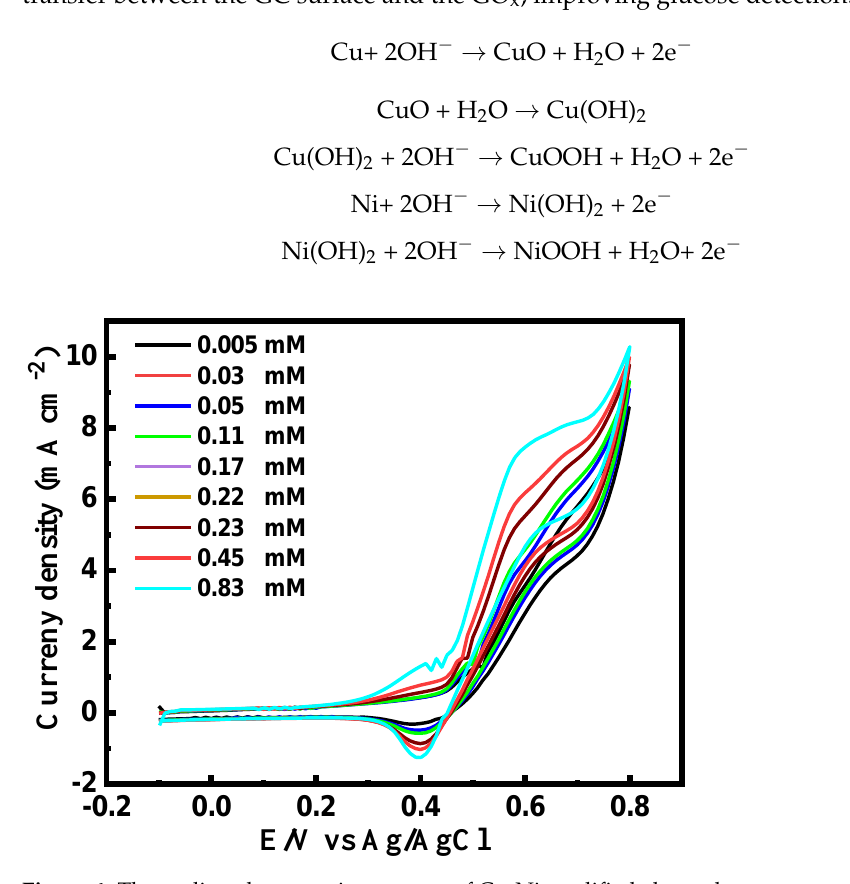
Figure 4. The cyclic voltammetric response of Cu-Ni modified electrode on sweat solution at pH 12 and a scan rate of 50 mV s −1 .